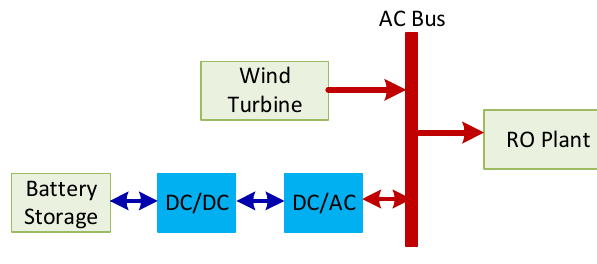
Figure 2. AC coupled configuration for the power line.